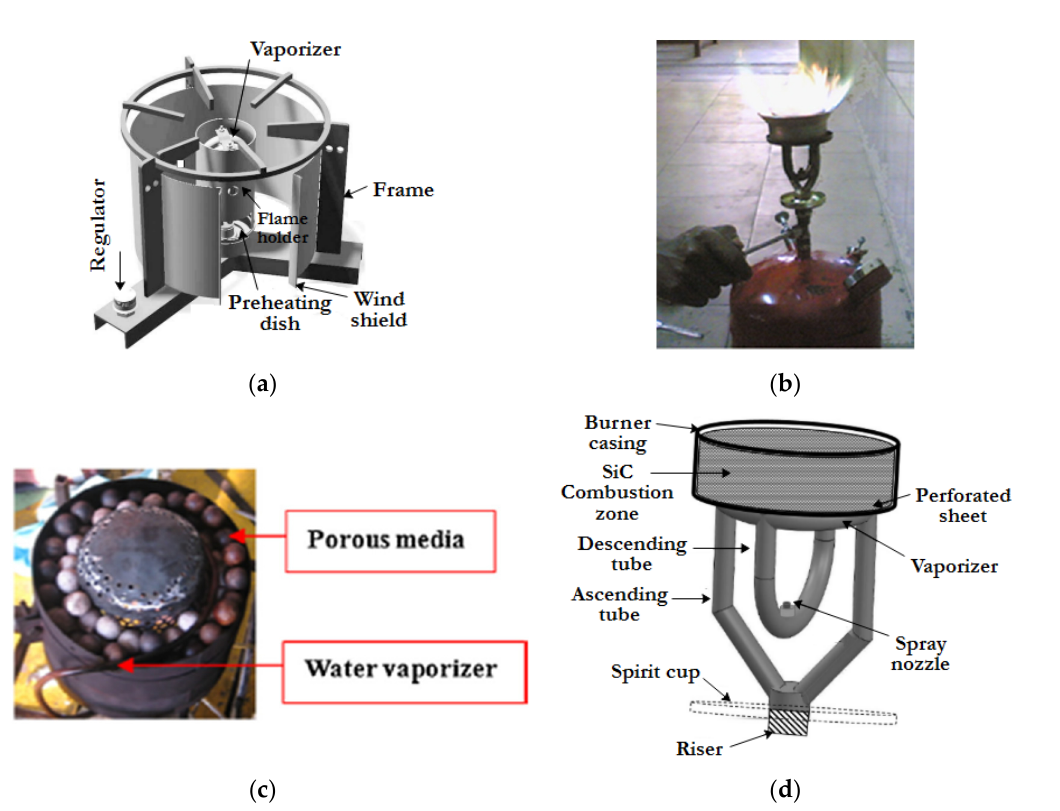
Figure 12. Cook-stoves for plant oil application. ( a ) Plant oil pressure stove (Protos) [73]; ( b ) Oil stove developed by Natarajan et al. [75]; ( c ) Waste vegetable oil burner system (with porous media) developed by Lapirattanakun and Charoensuk [81]; ( d ) PRB developed by Kaushik and Muthukumar [82]. Table 4. Summary of the plant oil-based cook-stoves.